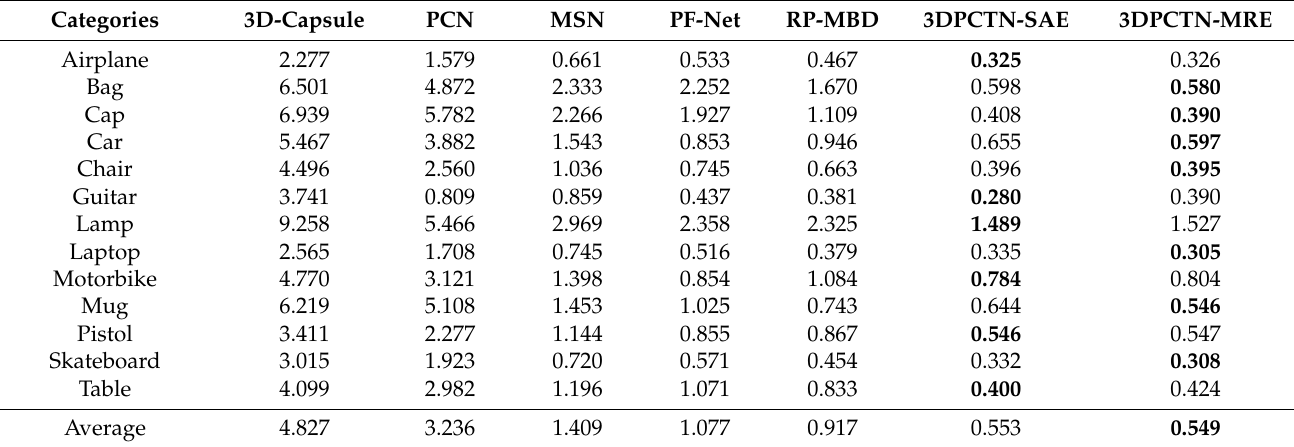
Table 1. Quantitative comparison between our methods and existing methods on